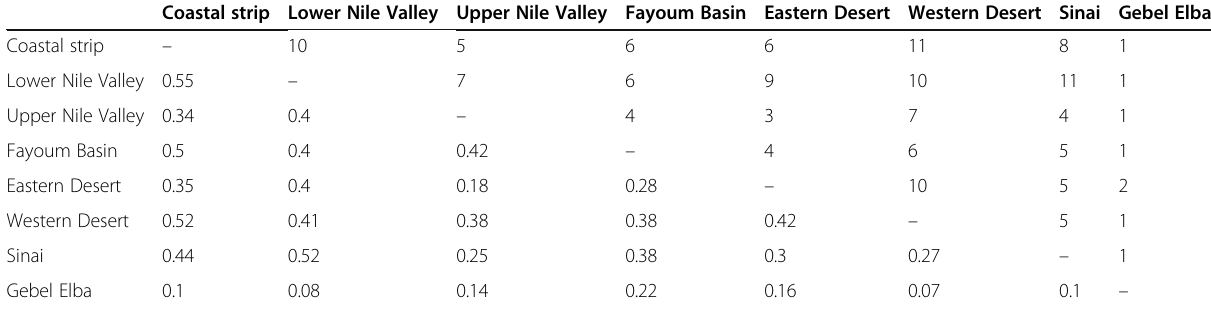
Table 3 The similarity of mantis faunas in the Egyptian ecological zones. The number of species shared between each pair of zones is given in the upper half of the table, and the Sørensen-Dice coefficient between each pair of zones is given in the lower half of the table Coastal strip – 10 5 Lower Nile Valley 0.55 – Upper Nile Valley 0.34 Fayoum Basin Eastern Desert Western